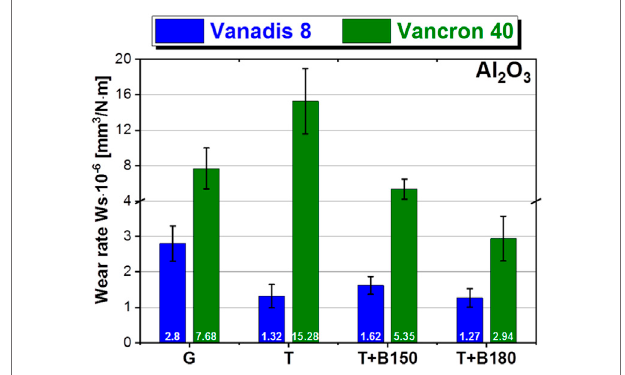
FIGURE8| WearratesforVanadis8andVancron40samples,following the mechanical processes of SL modi fi cations: (A) G, (B) T, (C) T + B150, (D) T + B180. Ball-on-disc tests carried out against Al 2 O 3 pins.